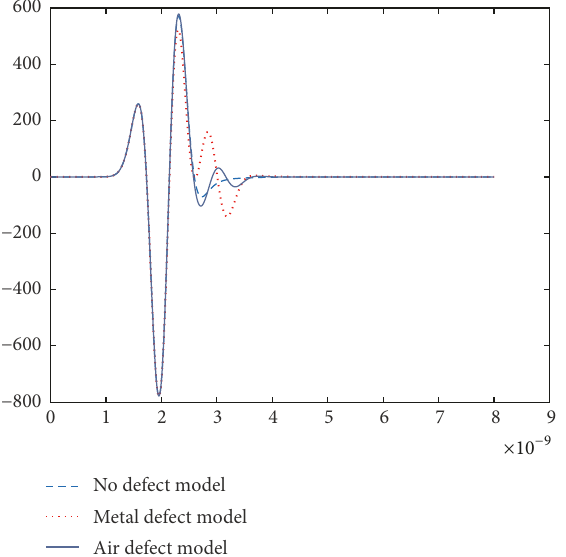
Figure 6: Comparison of A-scan scan data at the same array.